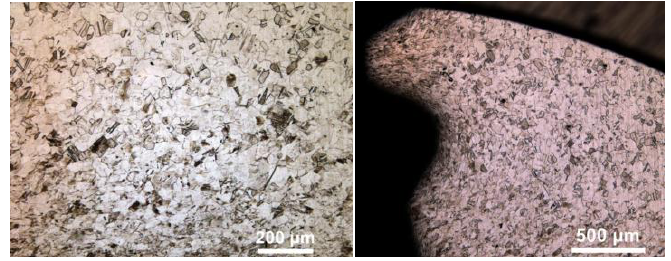
Figure 7. Completely austenitic microstructure of studs.